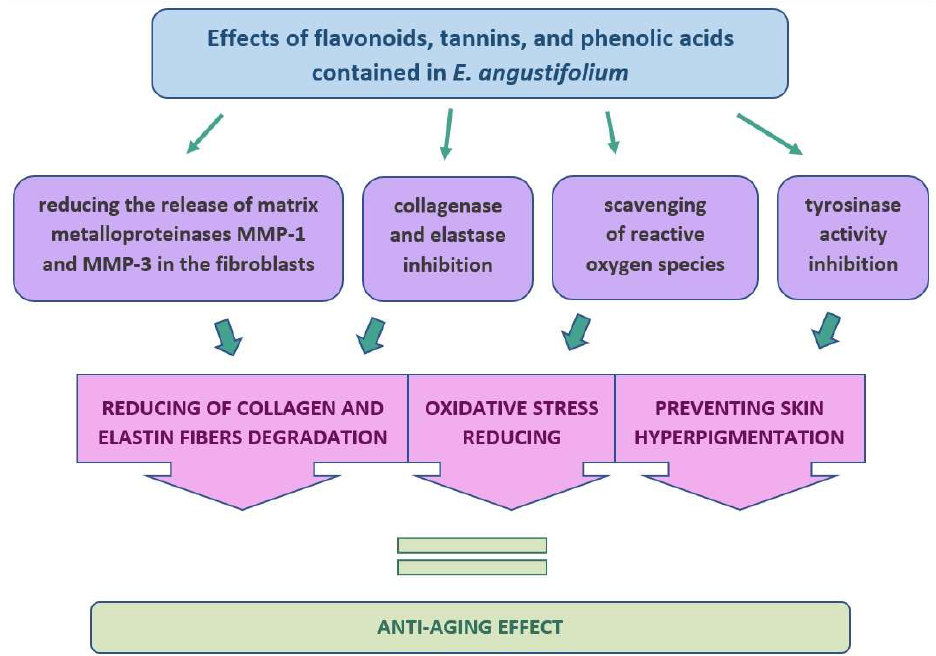
Figure 6. A diagram showing schematically the mechanism of the anti-aging effect of the ingredients contained in E. angustifolium contained in E. angustifolium.